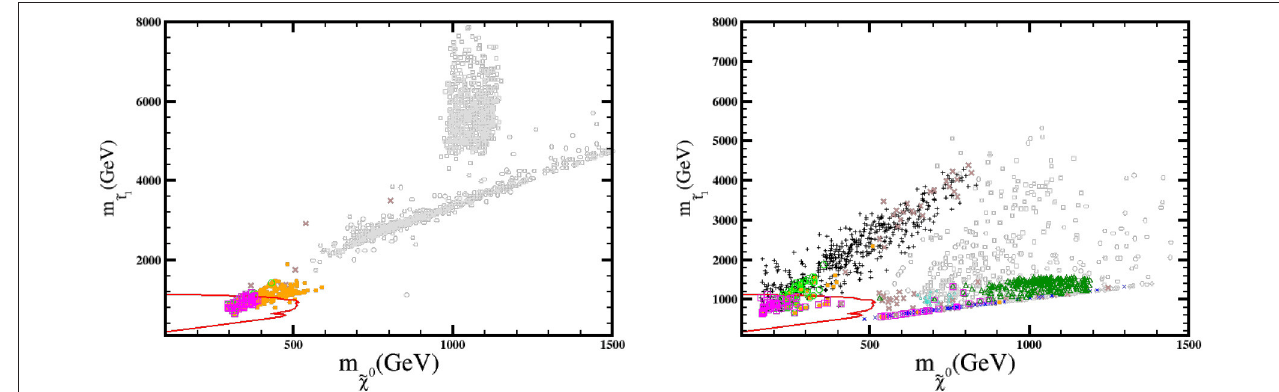
FIGURE 5 | As in Figure 3 for the m